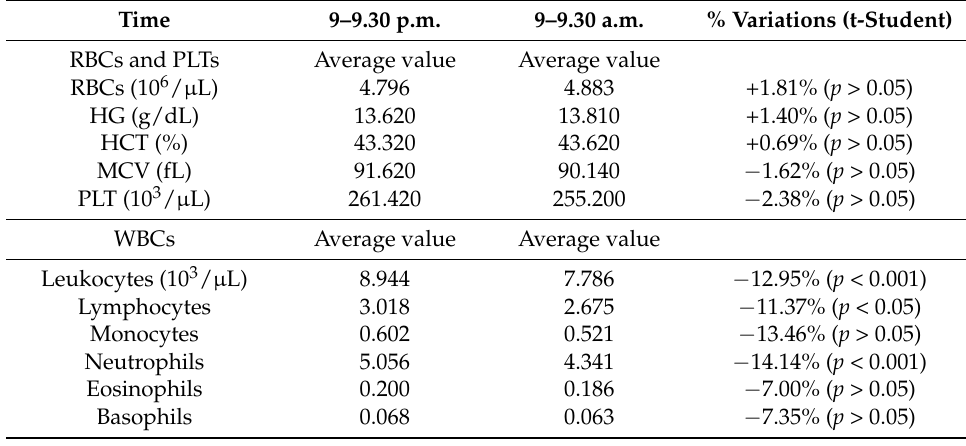
Table 2. Variations (p.m. vs. a.m.) of hemocytometric parameters in placebo